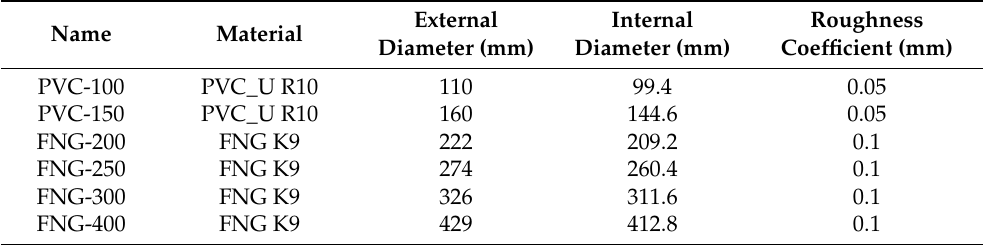
Table 2. Commercially available pipe diameters and materials, PVC and ductile cast iron (FNG), to be used in the design of the network blueprint for City